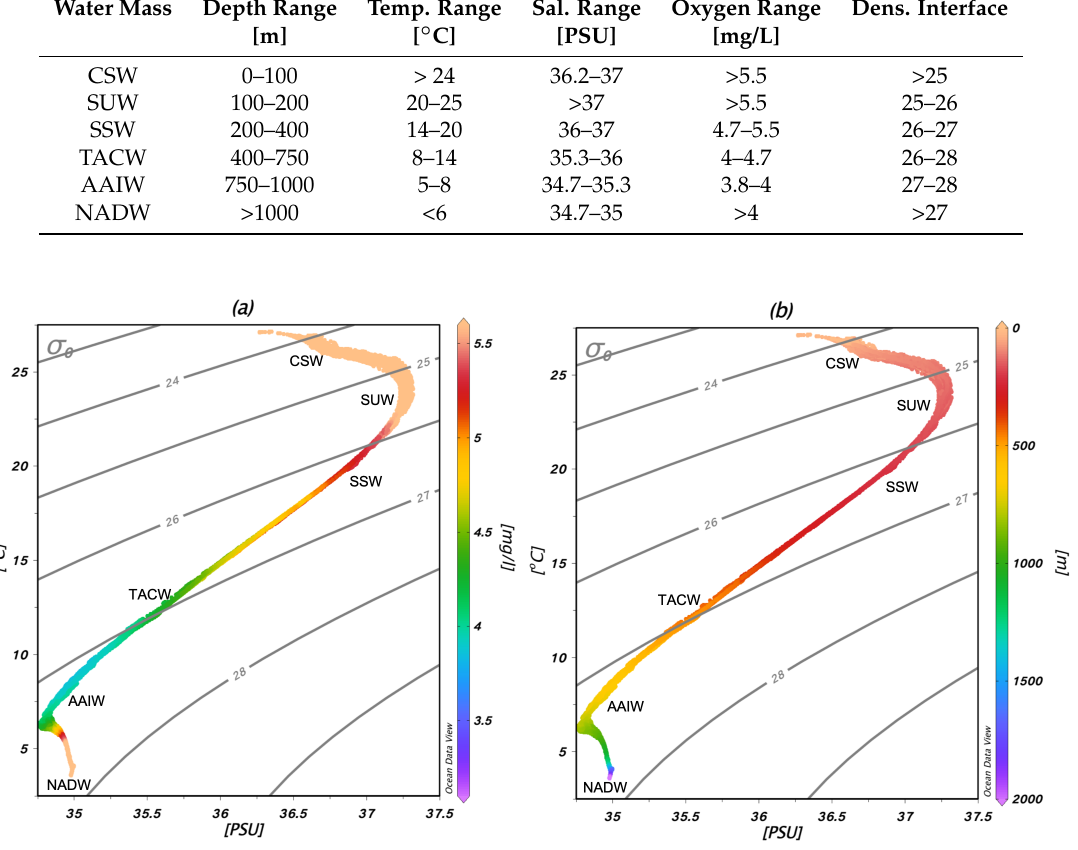
Figure 9. Temperature–Salinity diagrams from all sampled stations and different water masses in the region: Caribbean Surface Water (CSW), Subtropical Underwater (SUW), Sargasso Sea Water (SSW), Tropical Atlantic Central Water (TACW), Antarctic Intermediate Water (AAIW), and North Atlantic Deep Water (NADW). Colors represent ( a ) dissolved oxygen [mg/L] and ( b ) depth [m]. TS diagrams were generated using Ocean Data View